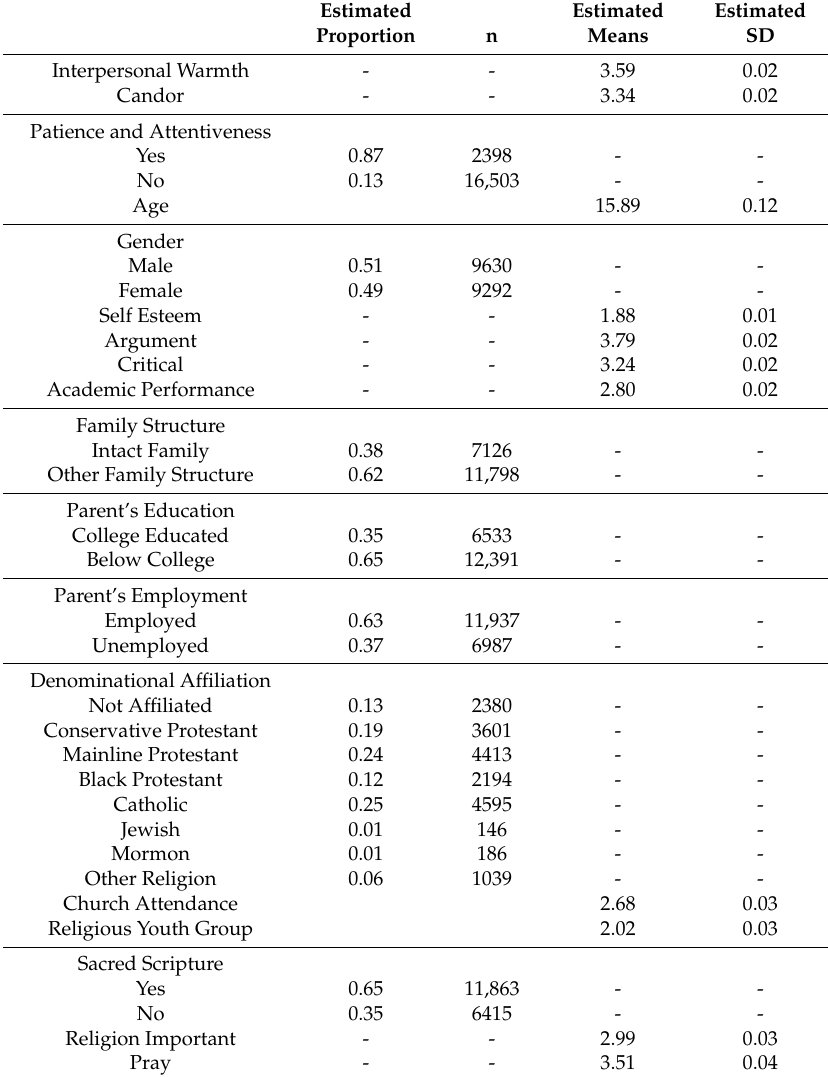
Table 1. The Sample Proportions and Means before Listwise